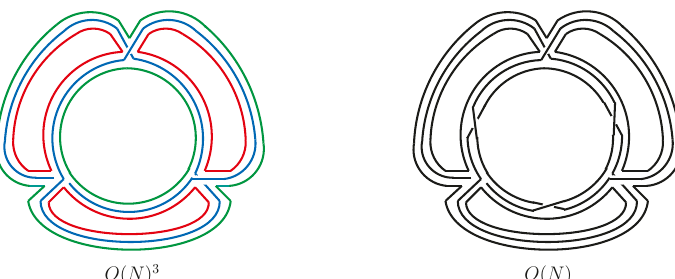
Figure 3 . Order g 3 stranded diagrams for O ( N ) 3 and O ( N ) theories. The diagram in the O ( N ) 3 theory has 6 loops and scales as g 3 N 6 ; the diagram in the O ( N ) theory has 7 loops and scales as g 3 N 7 .